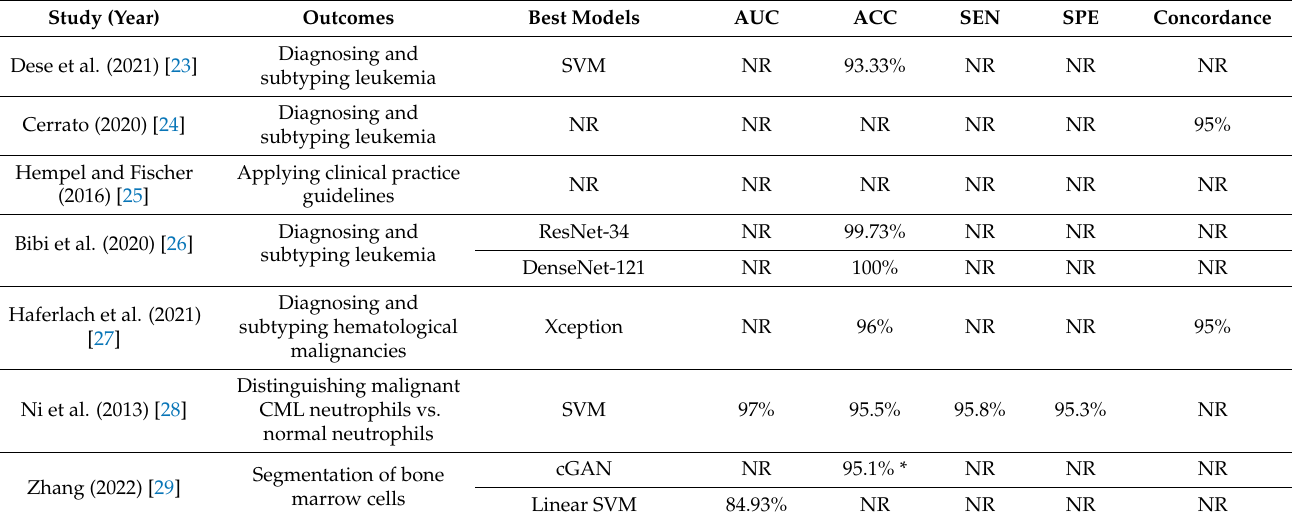
Table 2. Performance metrics for the best models in the included